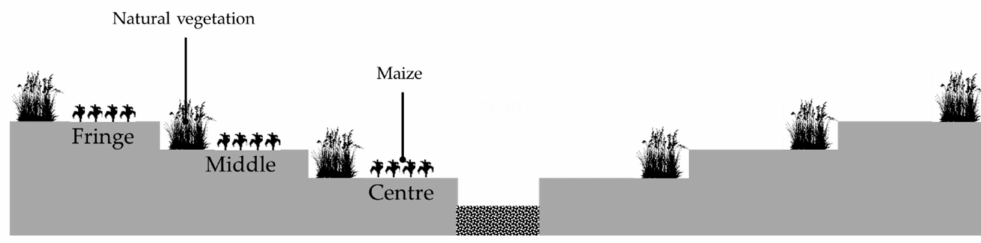
Figure 2. Cross-section of the inland valley showing the di ff erent hydrological positions and overview of experiment